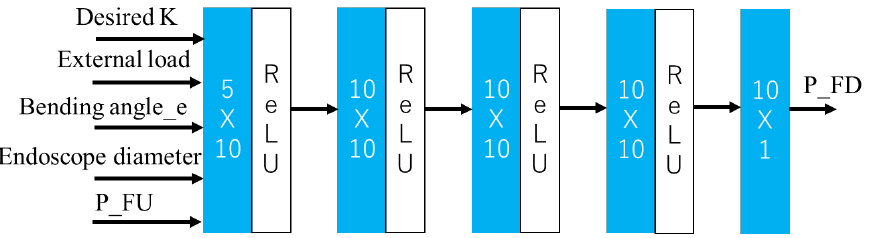
Figure 3. The architecture of NN-based inverse dynamic model.